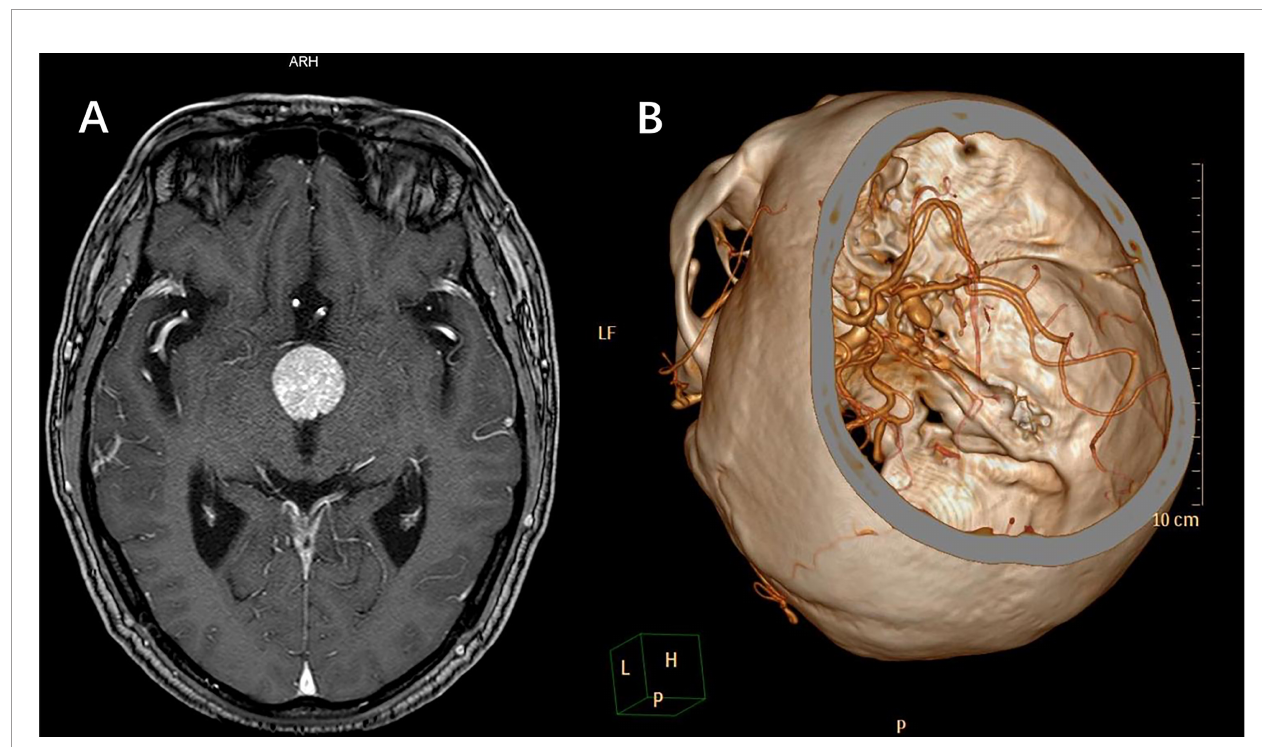
FIGURE 2 | A case of typical radiological pro fi le of sellar region lesion complicated with IAs. (A) MRI indicated sellar region lesion. (B) Further CTA revealed a partially thrombotic pseudoaneurysm formed from ruptured IA, and the IA located close to the sellar region lesion. In such occasion, incomplete preoperative examinations without CTA can lead to intraoperative massive hemorrhage, even perioperative